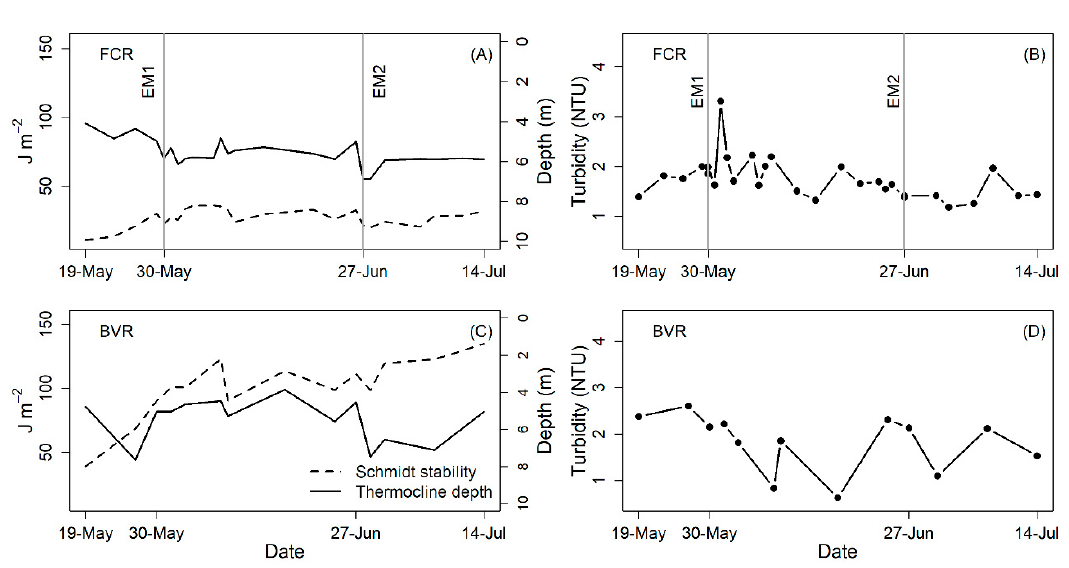
Figure 3. ( A , C ) Schmidt stability (left y -axis) and thermocline depth (right y -axis) in ( A ) Falling Creek Reservoir (FCR) and ( C ) Beaverdam Reservoir (BVR) during the two mixing experiments; ( B , D ) Turbidity in ( B ) FCR and ( D ) BVR during the mixing experiments. The two mixing events in FCR (EM1 and EM2) are denoted by vertical gray lines in ( A and B ).